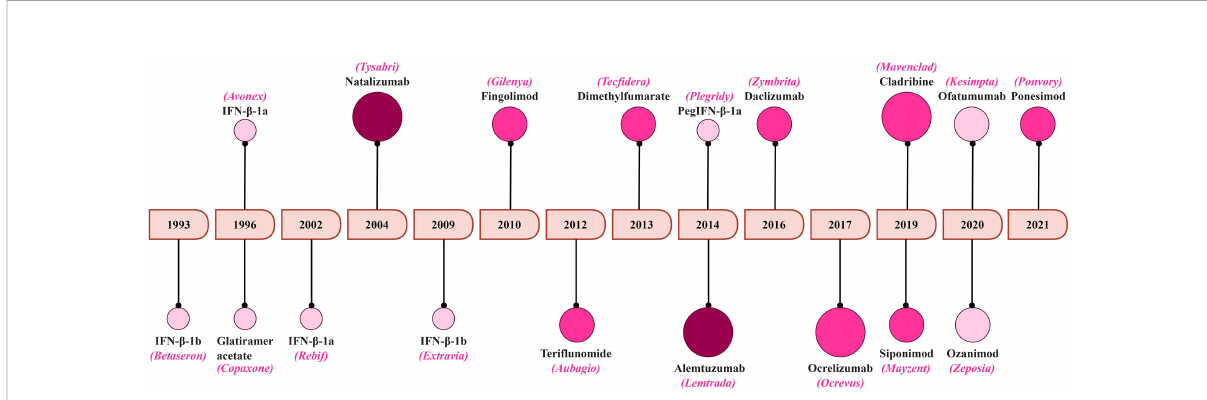
FIGURE 5 A timeline of FDA approval for MS therapeutics. The increasing color gradient in the circles indicates potential for higher toxicity, while the increasing size of the circles indicates higher ef fi cacy.